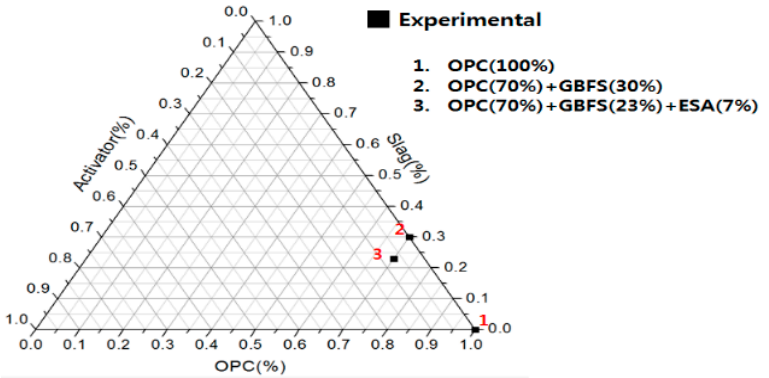
Figure 1. Mixing ratio of powders for different materials (%).